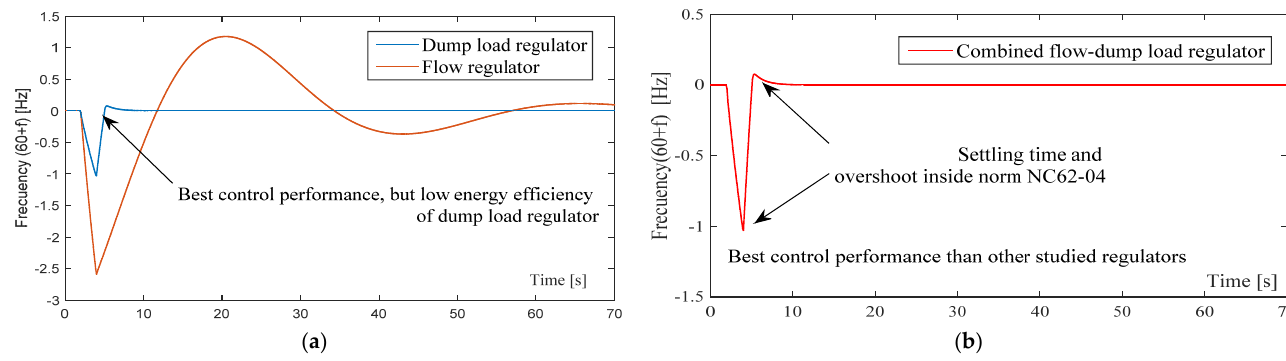
Figure 5. ( a ). Response to 11% impulse load. Independent flow and dump load regulators. ( b ). Response to 11% impulse load. Combined flow-dump load regulator.